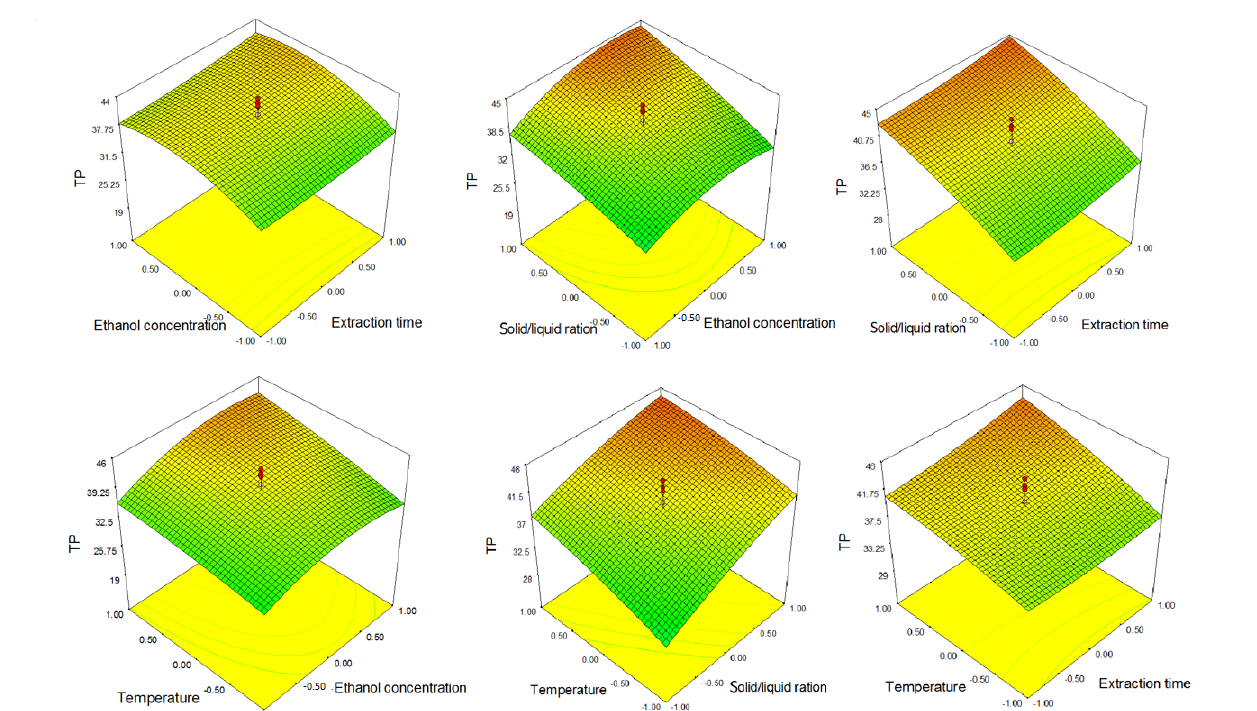
Figure 1. Response surfaces showing the combined effect of parameters on total phenolic content (TP). From the response surfaces (Figure 1), it can be seen that an increase in ethanol concentration to approximately 80% (coded value 0.5) had an increasing effect on TP, and a further increase in ethanol concentration led to its slight